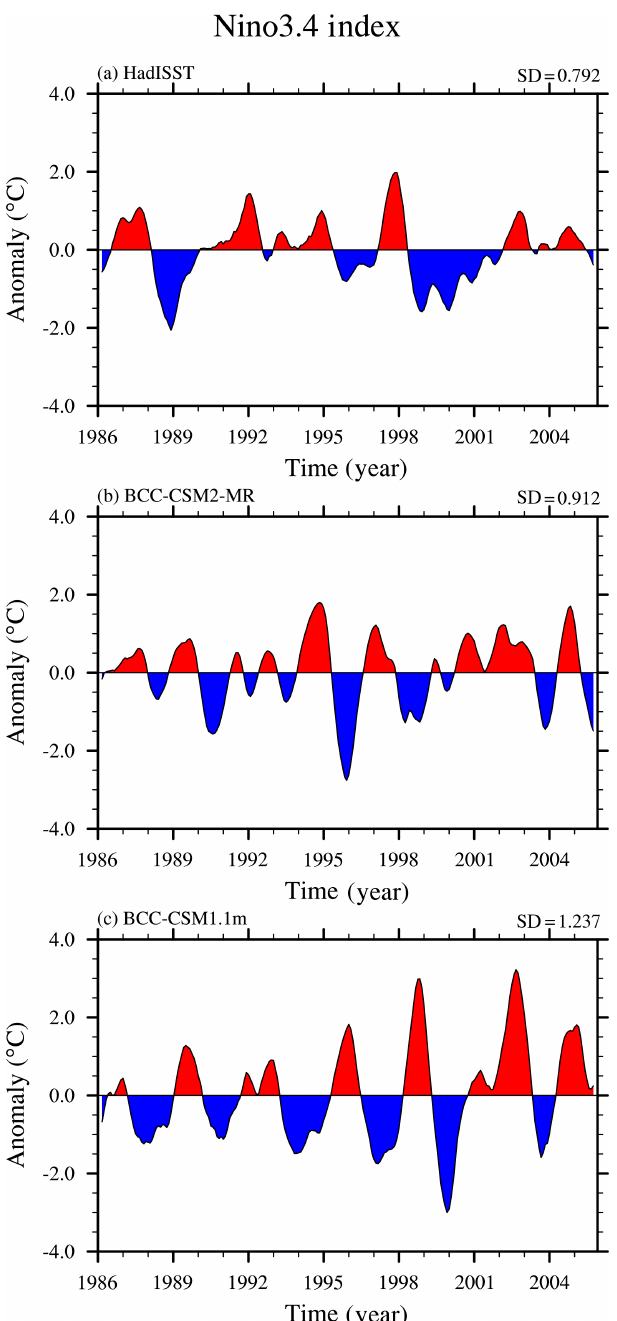
Figure 13. The time series of the Nino3.4 SST index from 1986 to 2005 for (a) HadISST data, (b) BCC-CSM2-MR, and (c) BCC-